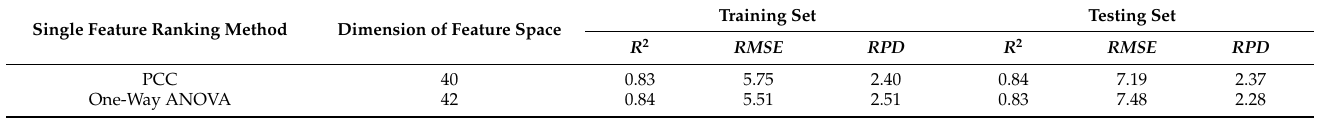
Table 4. The predictive performance of PLSR models established by single feature ranking